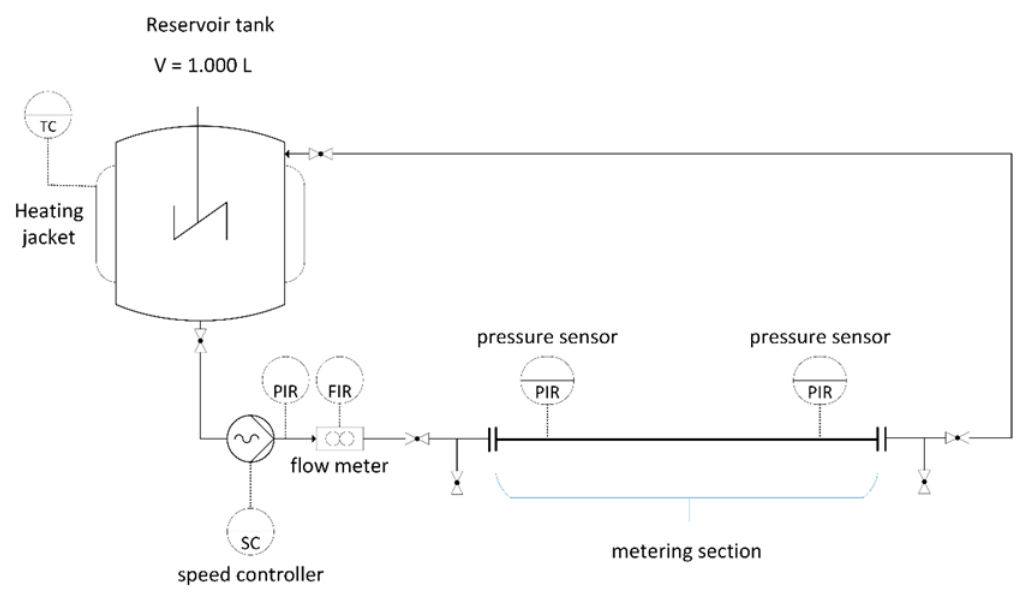
Figure 2. Scheme of the pipe viscometer.